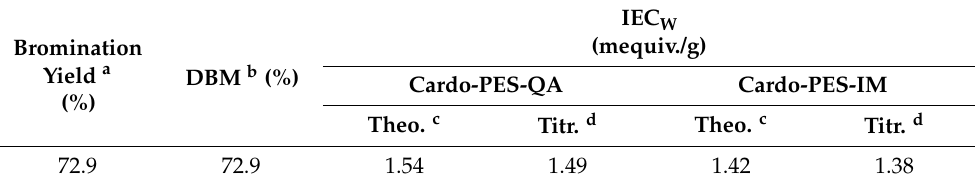
Table 2. Bromination and IEC of the polymers.